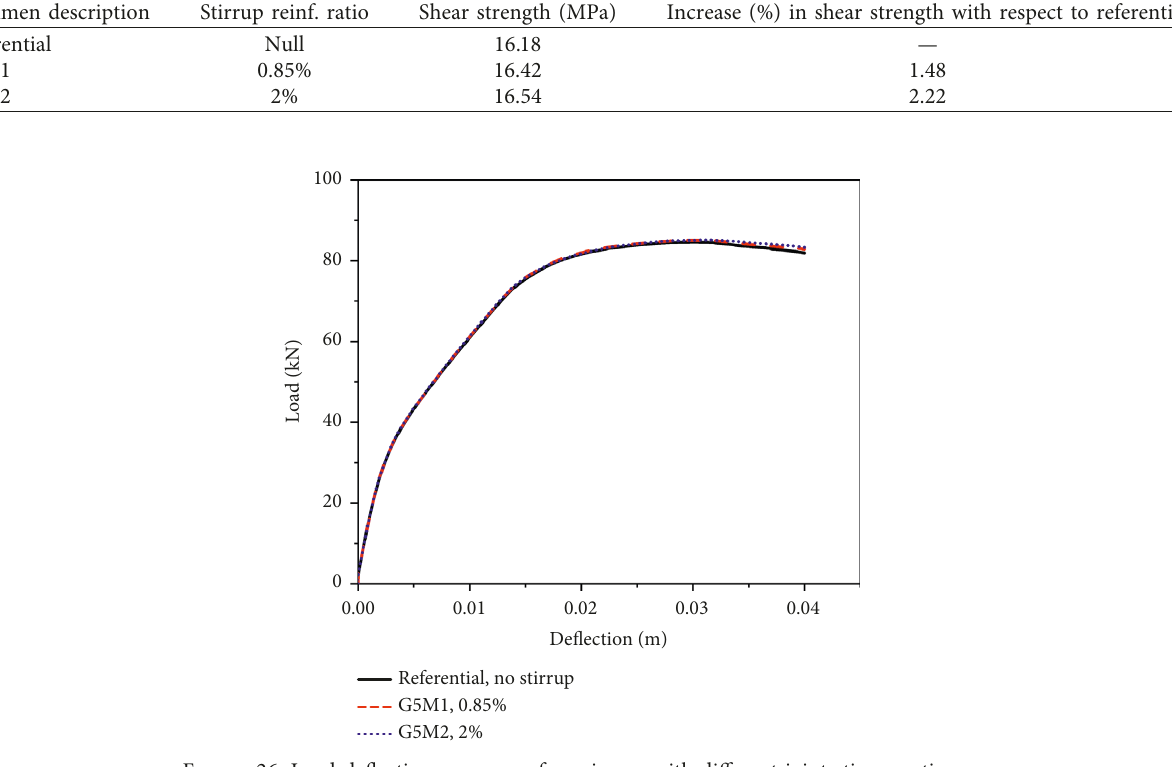
Figure 26: Load-deflection response of specimens with different joint stirrup